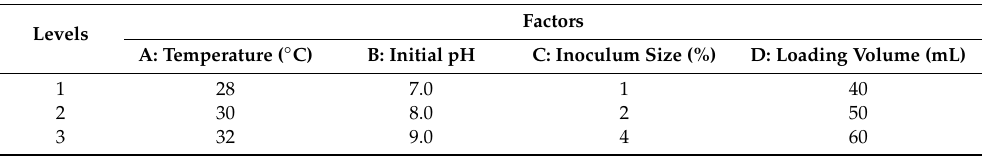
Table 1. Test factors and levels of the orthogonal test design.